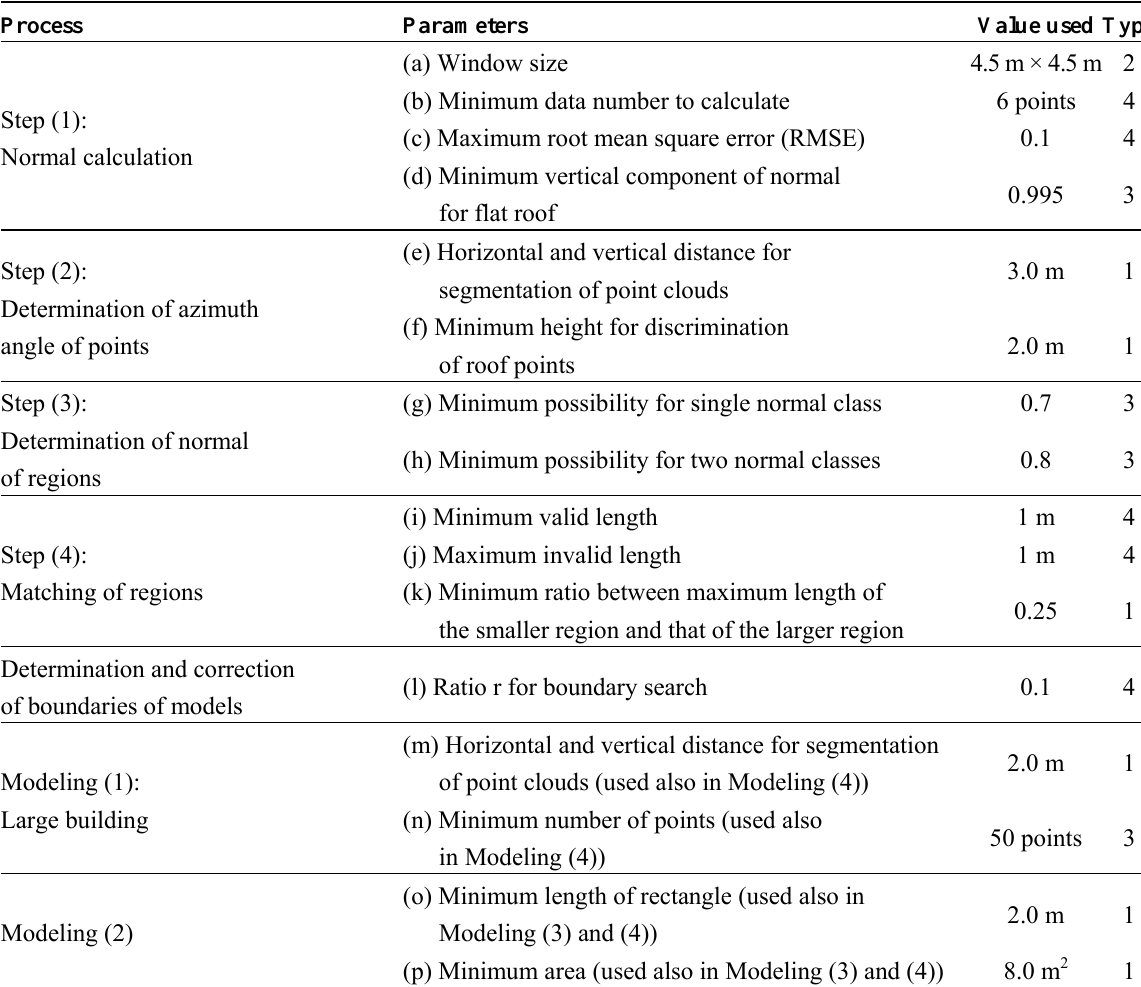
Table 1. Experimental parameter